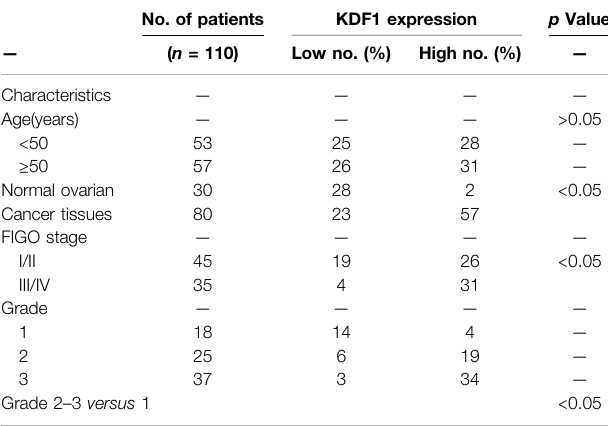
TABLE 2 | Relationship between clinicopathologic parameters and expression of KDF1 in 110 cases of ovarian cancer. No. of